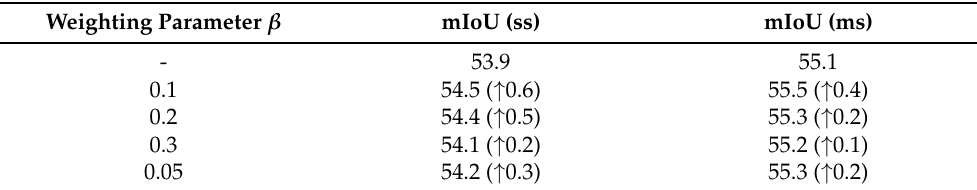
Table 3. Performance comparison of different weighting parameters β using the ADE20K validation set. ss: single-scale. ms: